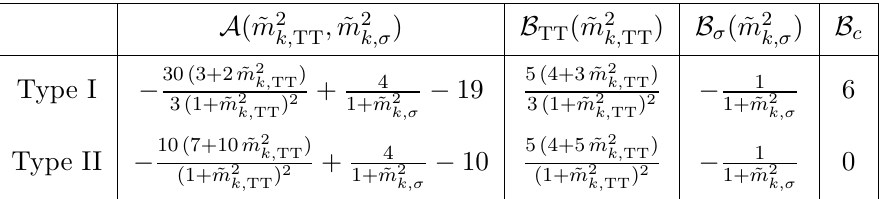
Table 1 . Explicit coe(cid:14)cients A ( ~ m 2 ; ~ m 2 ), B TT ( ~ m 2 ), B (cid:27) ( ~ m 2 ) and B c for two types of coarse- (cid:27) (cid:27) TT TT graining operators. Here, we use the nomenclature \type I" to designate the case where the coarse- graining operator corresponds to the Bochner-Laplacian (cid:1) B = (cid:0) (cid:22) r 2 . The nomenclature \type II" corresponds to the choice of Lichnerowicz-Laplacian de(cid:12)ned as (cid:1) L = (cid:0) (cid:22) r 2 + (cid:11) (cid:22) R (with (cid:11) = 2 = 3, (cid:11) = 1 = 4 and (cid:11) = 0, respectively, for transverse-traceless tensors, transverse vectors and scalars) on spherical